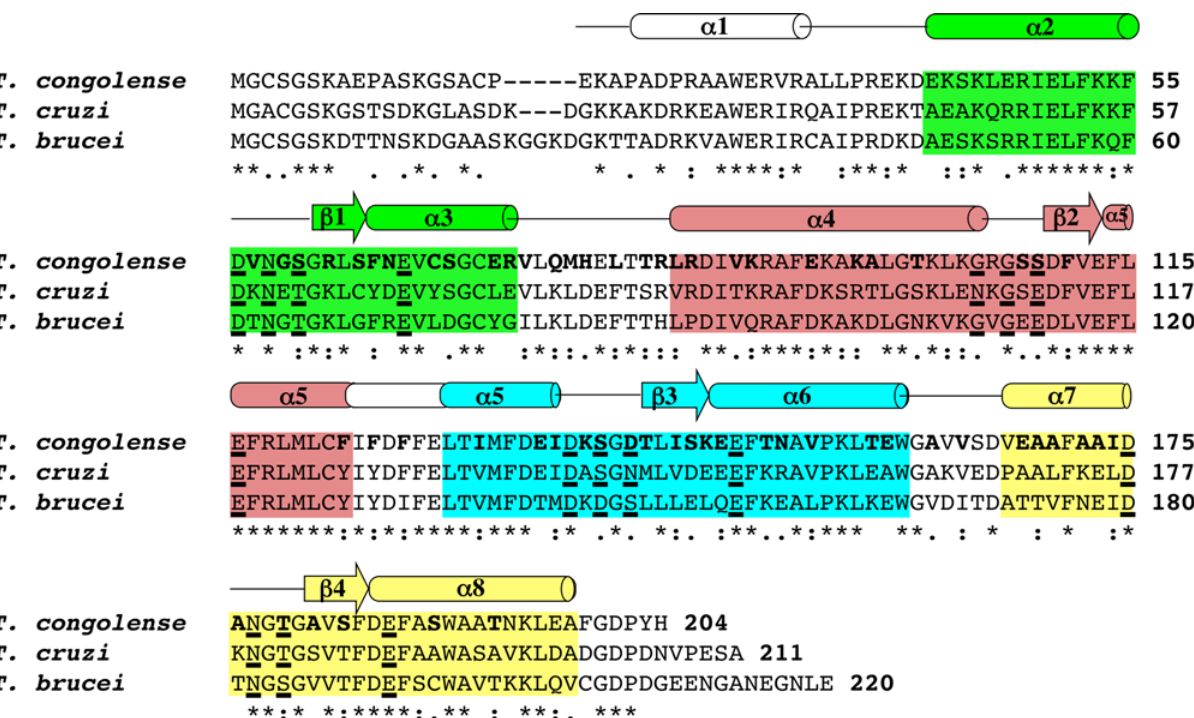
Fig 4. Primary sequence alignment of T . congolense calflagin with those of T . cruzi FCaBP and T . brucei Tb24. The secondary structural elements ( α - helices and β -strands) are depicted as cones and arrows, respectively, and were derived from the I-TASSER based structure prediction for T . congolense calflagin, the x-ray crystal structure of T . cruzi FCaBP (3CS1) and the NMR data for T . brucei Tb24 (2LVV). The four EF-hands (EF1, EF2, EF3, and EF4) are highlighted in green, salmon, cyan, and yellow, respectively. Residues in the 12-residue Ca 2+ binding loops at position 1, 3, 5 and 12 are underlined. Invariant basic residues on the protein surface that are associated with membrane binding are colored blue. Non-conserved surface-exposed residues are highlighted using bold print.